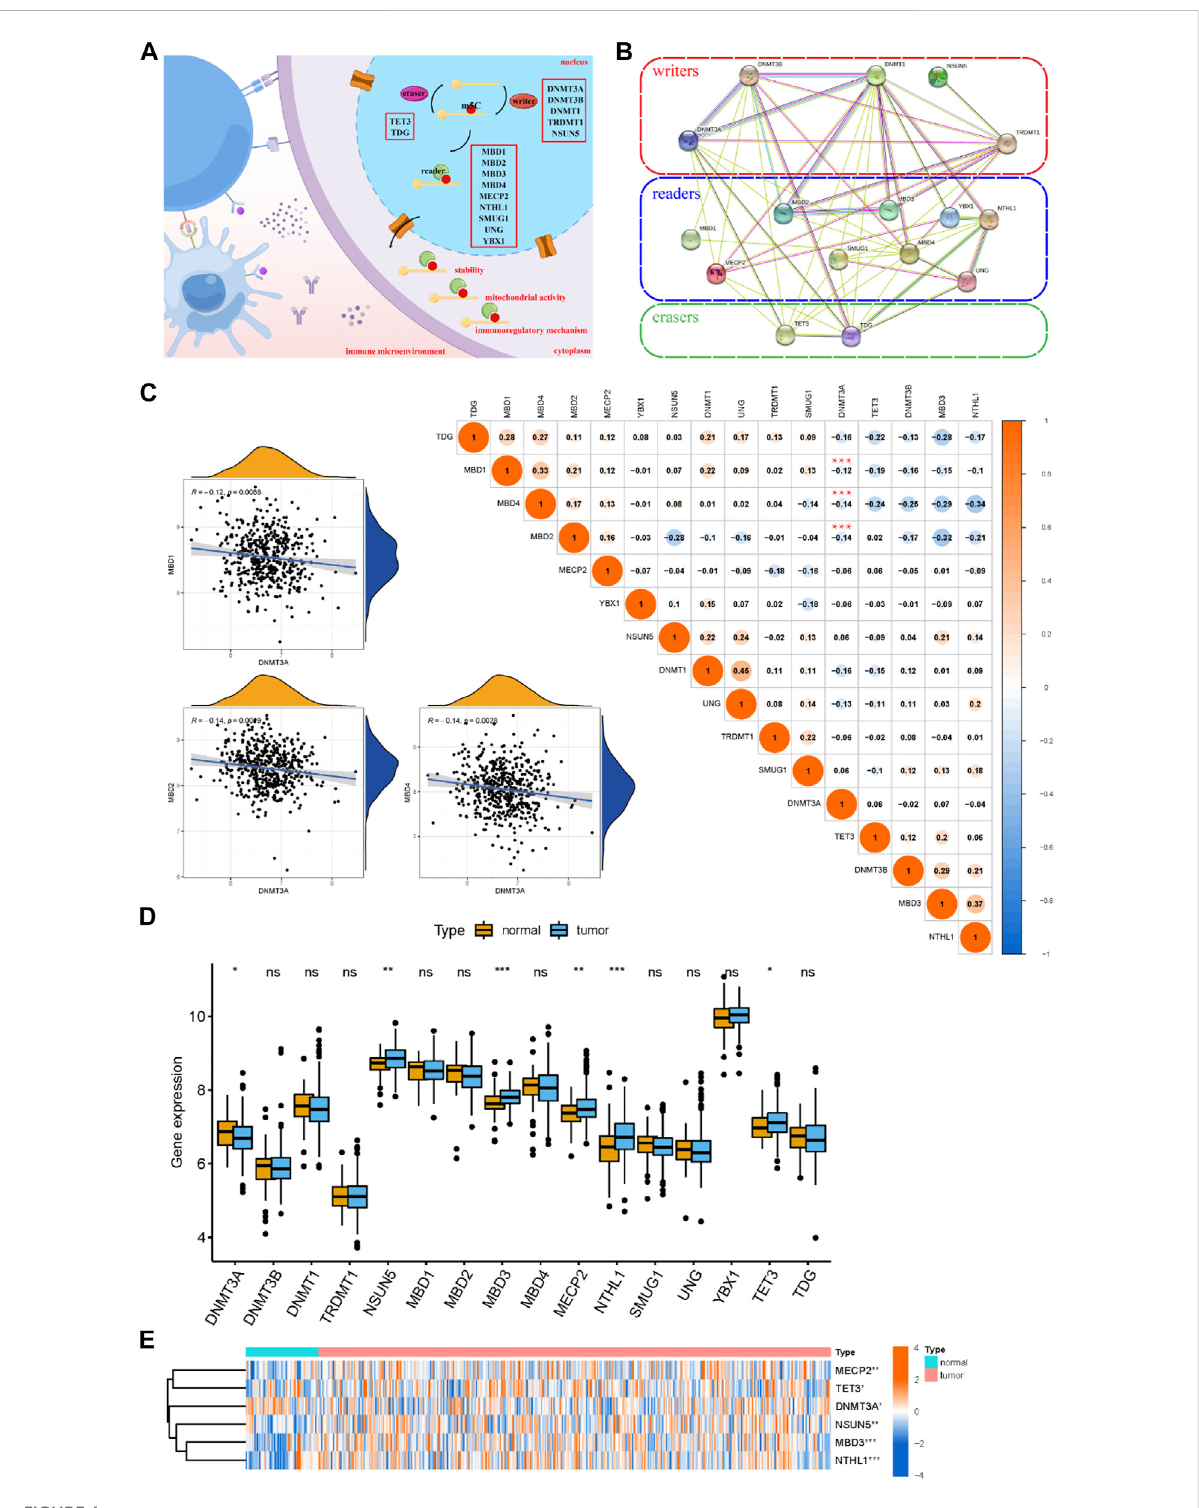
FIGURE 1 Landscape of m 5 C methylation regulators for healthy and MM samples. (A) The biological functions of m 5 C regulators, which are regulated by “ writers, ”“ readers, ” and “ erasers ” intheimmunemicroenvironment. Thediagram wasdrawnusingFigdraw(https://www. fi gdraw.com). (B) Overview of the composition of m 5 C regulators and the PPI network among 16 m 5 C regulators in the STRING online database. (C) Correlation analysis of the m 5 C regulators. The size of each circle represents the correlation coef fi cient (negative values in blue and positive values in red). *** p < 0.001. Scatterplotsshowsigni fi cantcorrelationsbetweenDNMT3AandMBD1,DNMT3AandMBD2,andDNMT3AandMBD4. (D,E) Boxplotandheatmapof the expression level of the m 5 C regulators for the healthy and MM